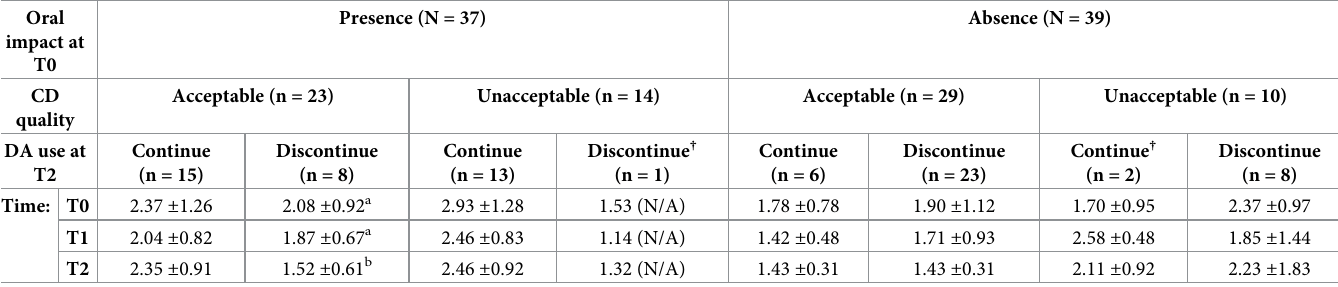
Table 3. Peanut particle size (mm; mean ± SD) at each time